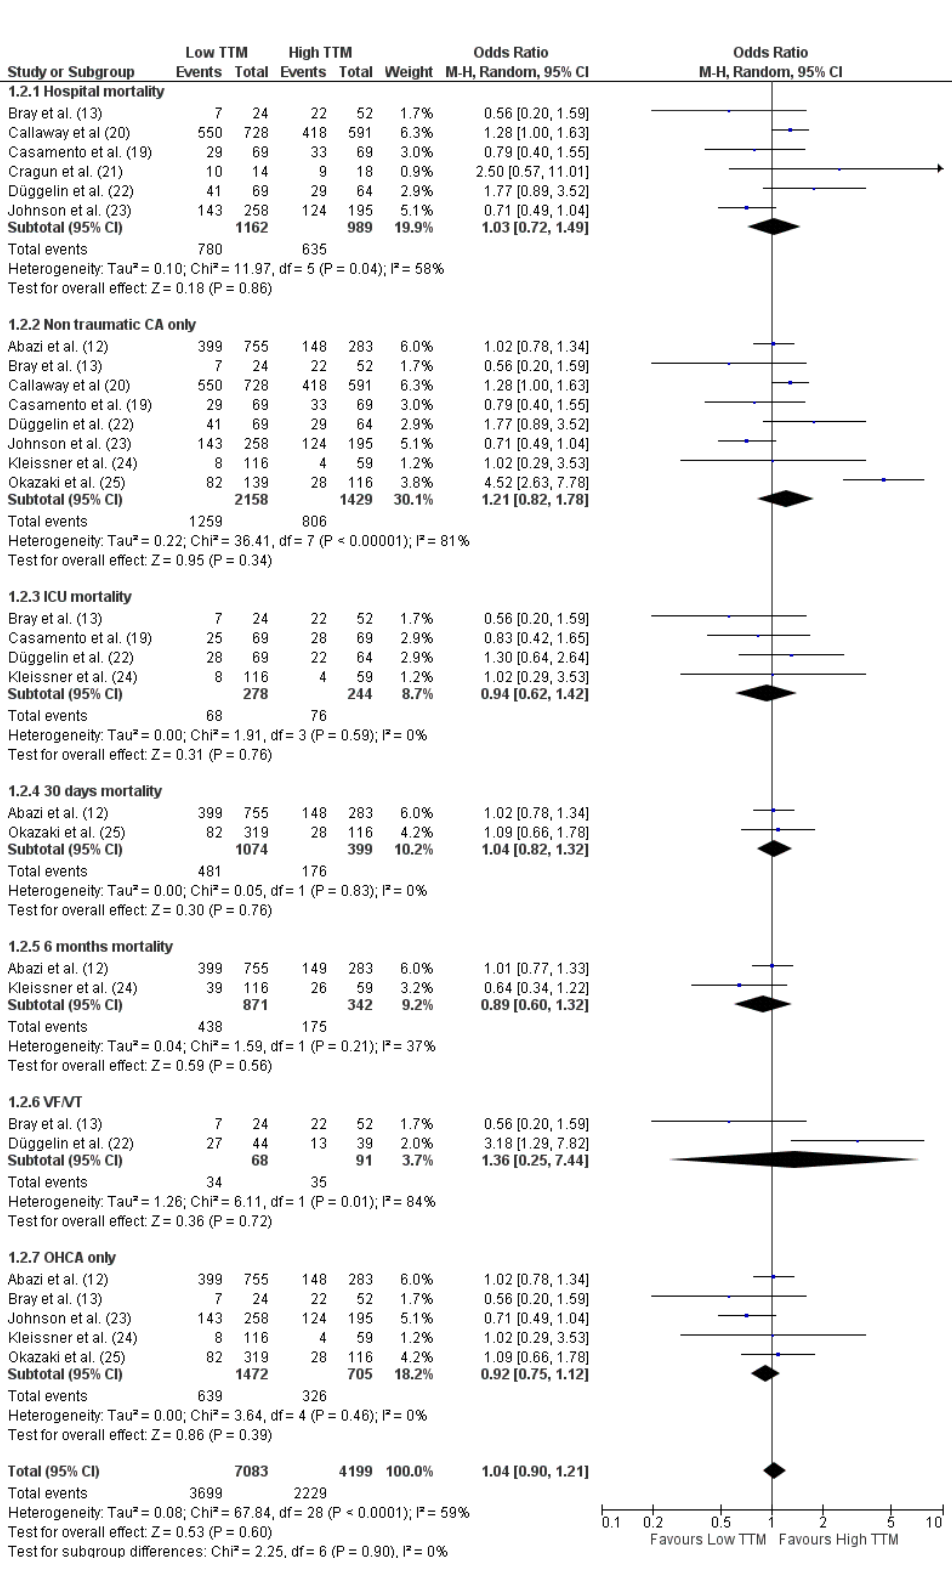
Figure 4. Forest plot for mortality in all patients at different time-points. Low TTM = TTM at 33 ◦ C; High TTM = TTM at 36 ◦ C. The size of the squares for the risk ratio reflects the weight of the trial in the pooled analysis. The horizontal bars represent 95% confidence intervals (CIs). OHCA = out-of-hospital cardiac arrest; VF/VT = ventricular fibrillation/ventricular tachycardia